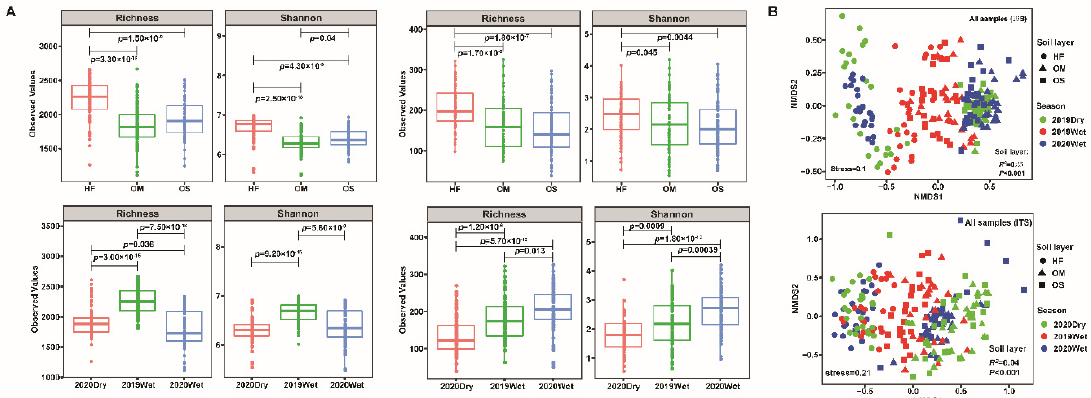
Figure 1. Soil layer effects on the soil microbiome. ( A ) Comparative analysis of the alpha diversity of the bacterial (left) and fungal (right) community. ( B ) Non-metric multidimensional scaling (NMDS) ordinations based on Bray–Curtis distance of bacterial (up) and fungal (down) community composition across all samples. HF: humic fragmented litter, OS: organic soil, OM: organic mineral soil. 2019Wet: samples collected from wet season in 2019; 2020Dry and 2020Wet: samples collected from dry season and wet season in 2020.